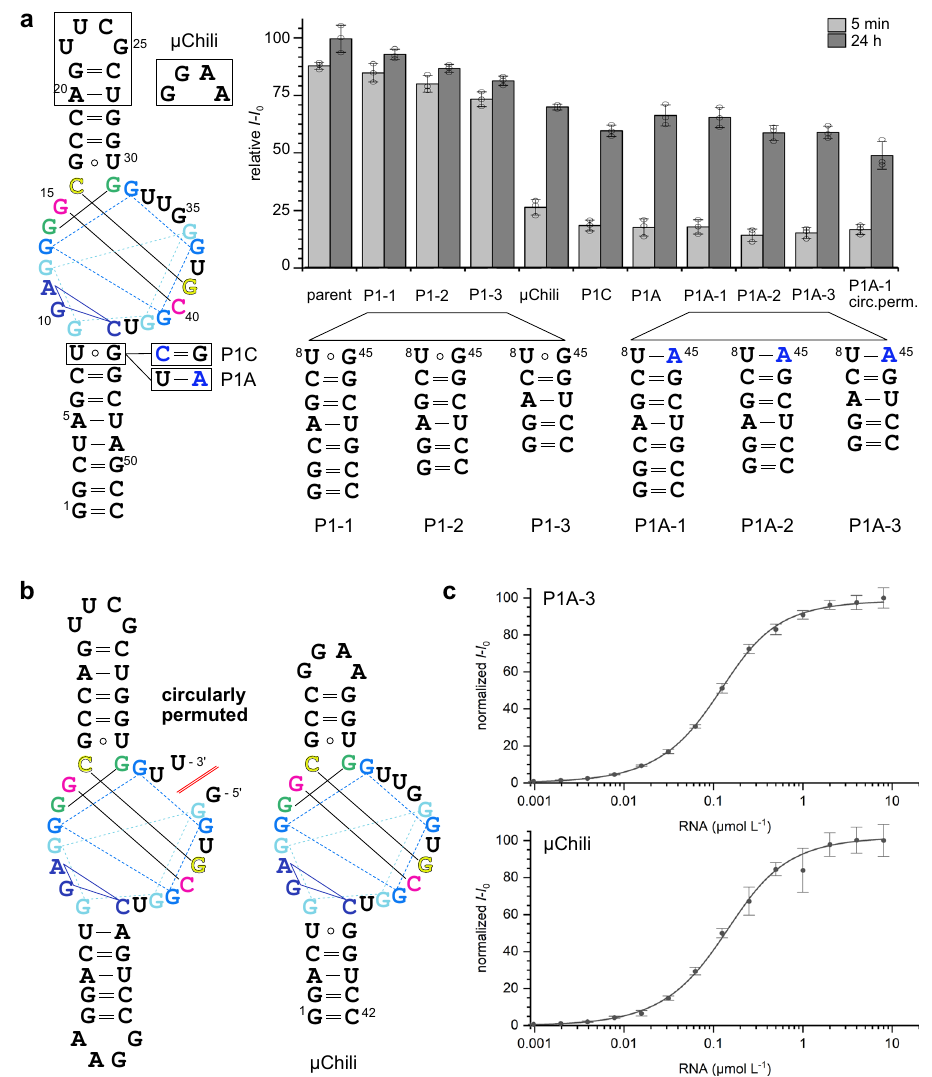
Fig. 5 Minimization and circular permutation of the Chili aptamer. a Mutations and truncation of the stems P1 and P2 of the parent Chili RNA are well tolerated. Fluorescence intensities of the corresponding Chili – DMHBI + complexes, upon incubation for 5 min and 24 h, relative to the parent complex. (1 µ M RNA and ligand). n = 3 independent experiments, mean ± SD. b Secondary structures of the circularly permuted Chili aptamer and µ Chili. c Titration curves of DMHBI + (0.1 µ M) with increasing RNA concentration demonstrate tight binding. K D = 68 nM for P1A-3 and 89 nM for µ Chili, respectively. Normalized fl uorescence intensity is plotted versus RNA concentration. Data were presented as mean values ± SD ( n = 3 independent titration experiments).